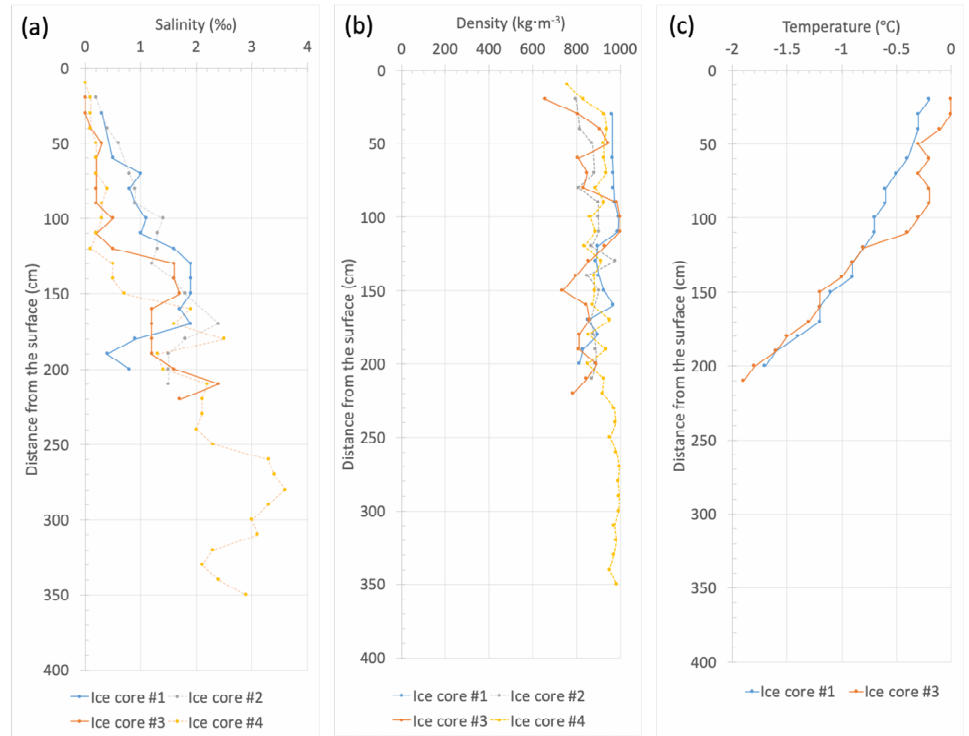
Figure 2. (a) Salinity, (b) density, and (c) temperature profiles of the extracted ice cores during the field campaign during August 12-15 in 2019 represent the characteristics of multi-year sea ice with low salinity and density on the top